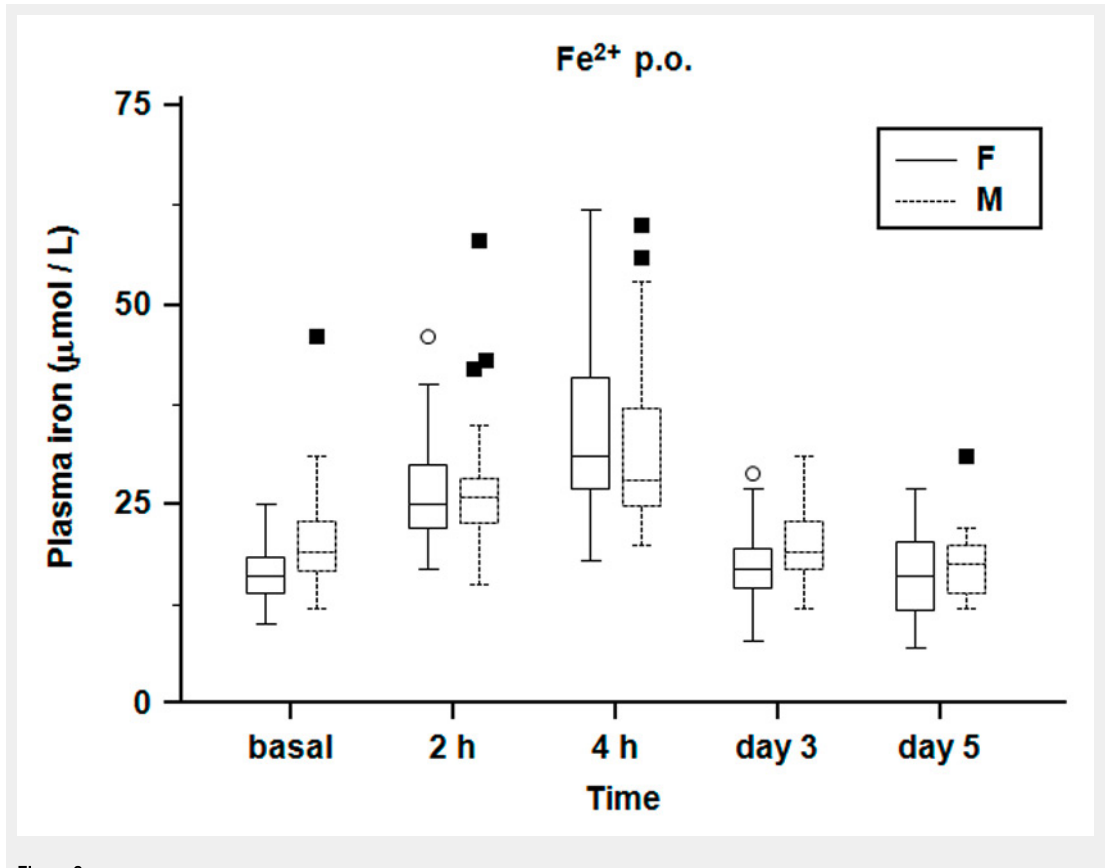
Figure 2 Absolute plasma iron concentration. Box and whiskers plot representing the median, first and third quartiles and the range of plasma iron concentration after ingestion of bivalent ferrous fumarate. Outliers are shown as circles (females) and squares